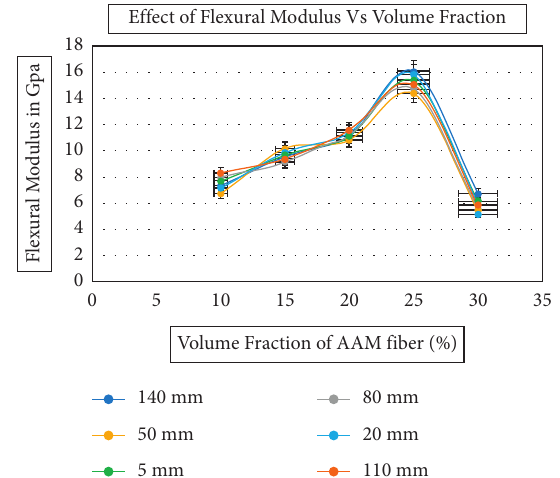
Figure 4: The relationship between the flexural modulus and the volume fraction of AAM fibers with varying fiber lengths.